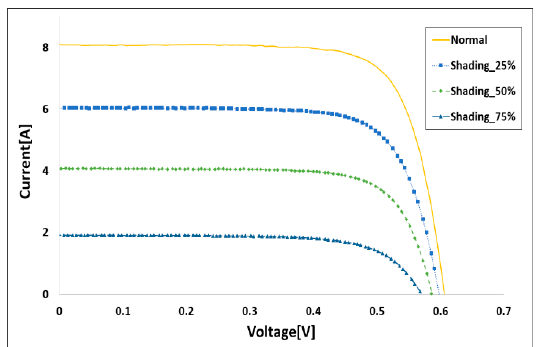
Figure 15. Current-voltage characteristic curve according to the shading ratio.